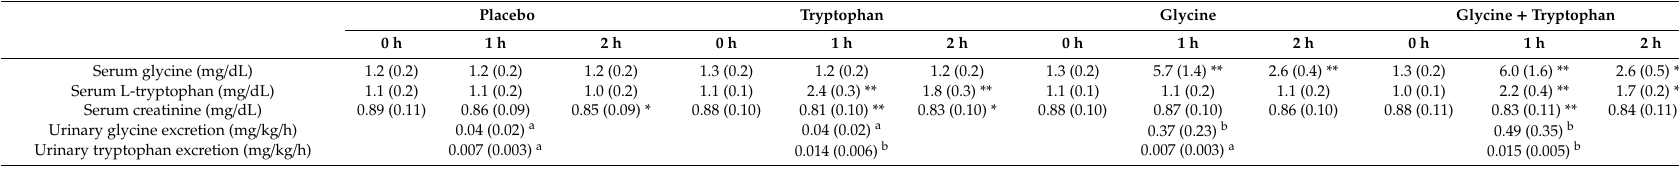
Table 5. Comparison of serum glycine and tryptophan concentrations and urinary glycine and tryptophan excretion among the placebo and amino acid groups. Placebo Tryptophan Glycine Glycine + Tryptophan 0 h Serum glycine (mg /